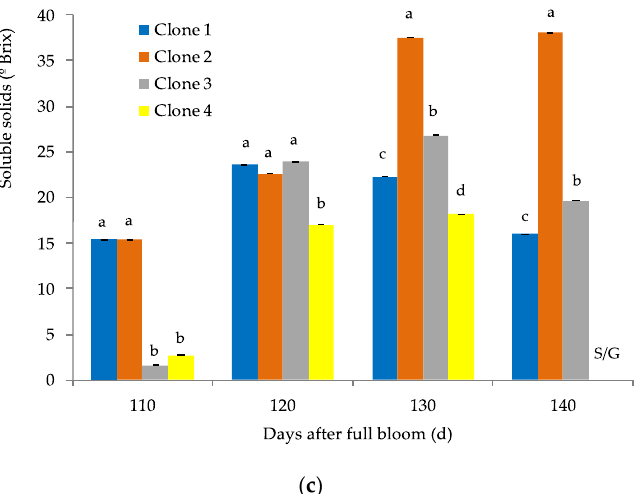
Figure 2. Fruit quality and weight parameters for four calafate clones according to different harvest dates: ( a ) fruit weight; ( b ) equatorial diameter; ( c ) soluble solids. Capital letters indicate significant differences between the different clones for the same harvest date, according to the Fischer test ( p < 0.05). Lowercase letters indicate significant differences in comparison between the different harvest dates for the same calafate clone, according to the Fischer test ( p < 0.05). S/G = no harvest.